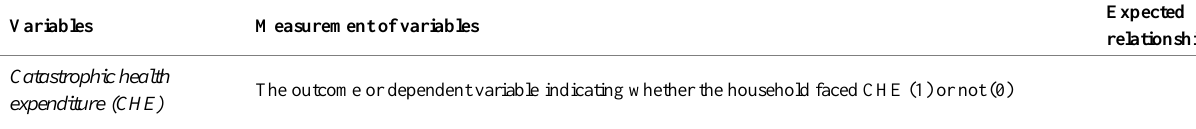
Table 1. Measurement of variables incorporated in the catastrophic health expenditure